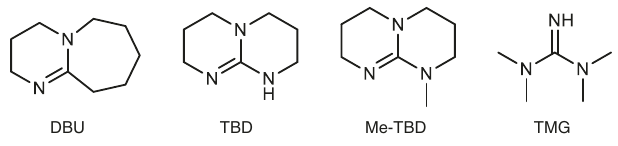
Fig. 1 Molecular structures of dopants containing the amidine